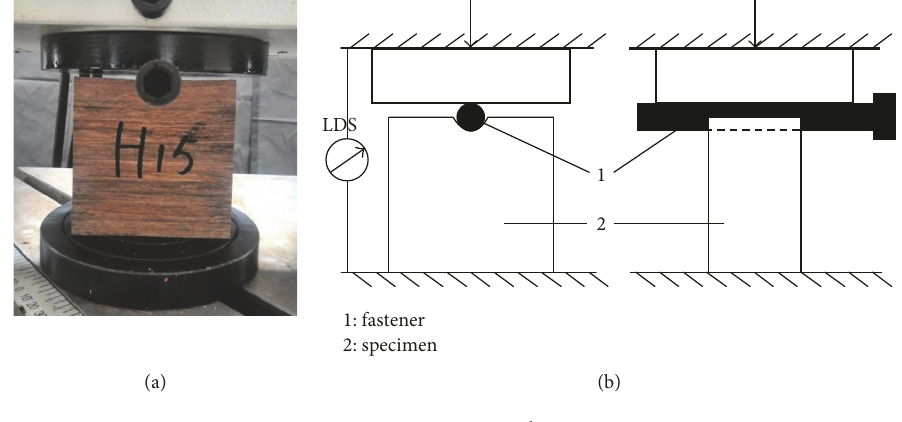
Figure 3: Experimental setup.